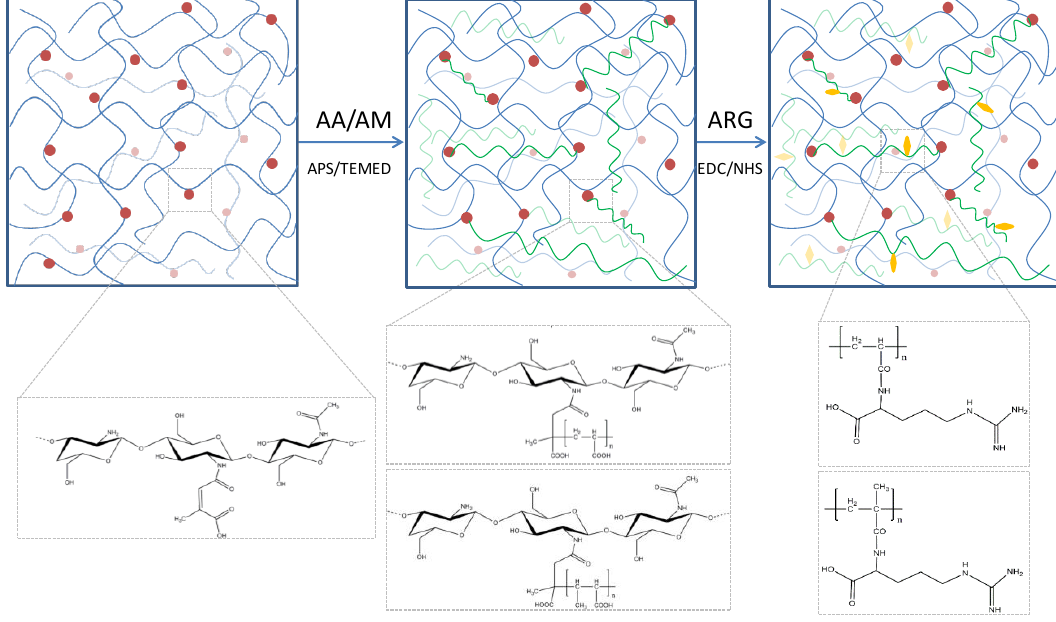
Figure 1. Schematic representation of the hydrogel network.